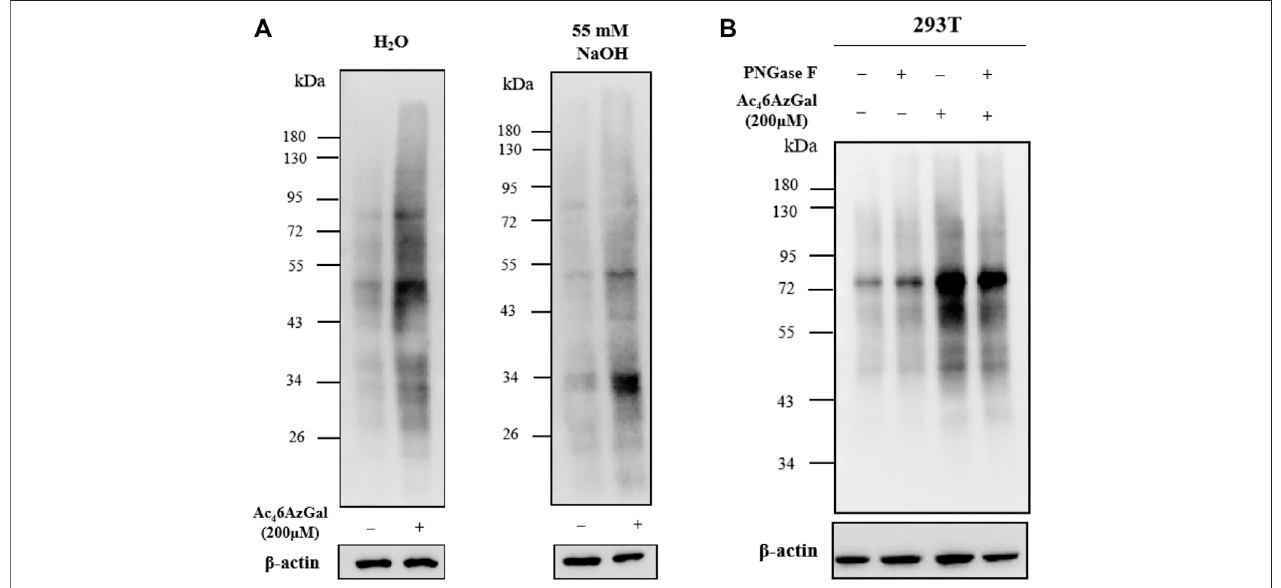
(A) Ac 4 6AzGal is not incorporated into the N-linked glycans;